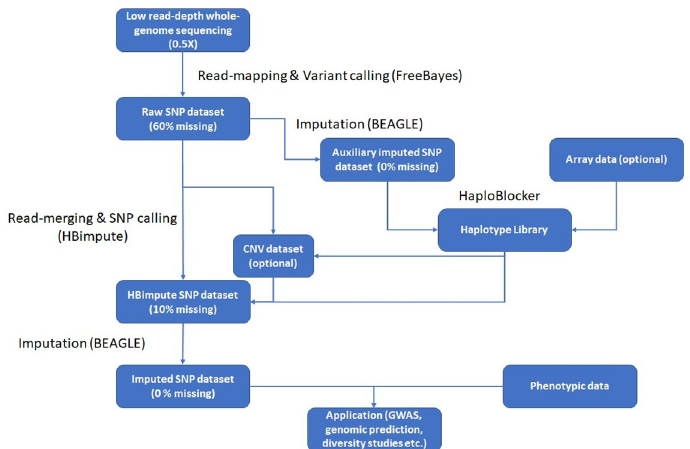
Fig 1. Schematic overview of the HBimpute pipeline. The values in brackets indicate the share of missing values in each step for the maize data set with 0.5X sequencing depths.